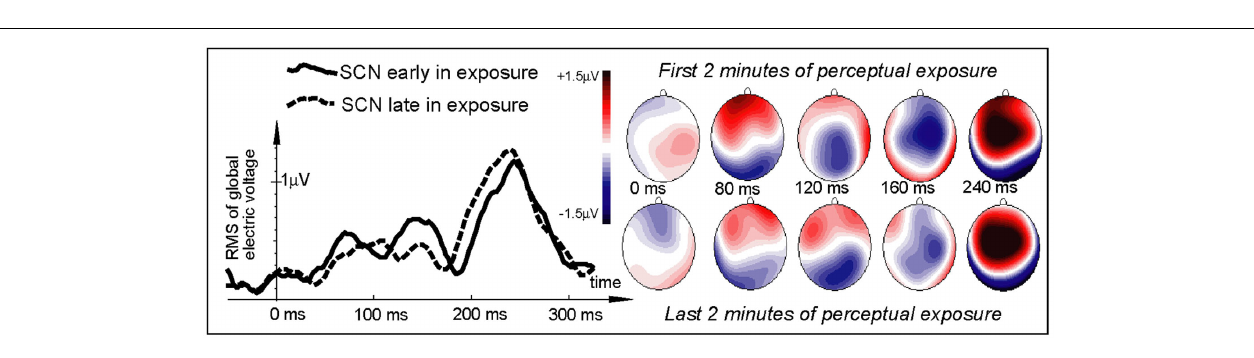
session. Note the marked difference in the SCN time course from that elicited by the spoken stimuli (cf. Figure 3 ). No significant exposure-related differences could be located for this non-speech elicited